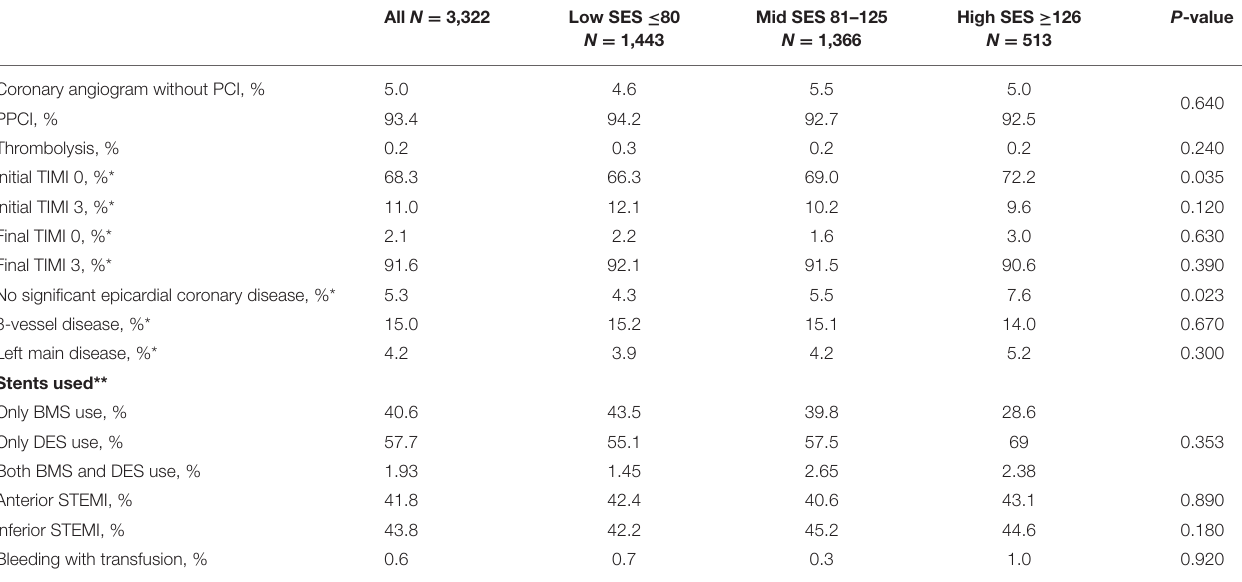
TABLE 2 | Primary reperfusion procedure in the “Codi IAM” network during the period 2010–2016 according to SES.